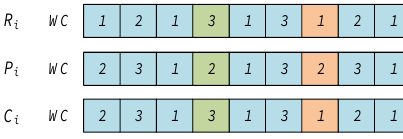
Figure 6. Updating process for individual WC